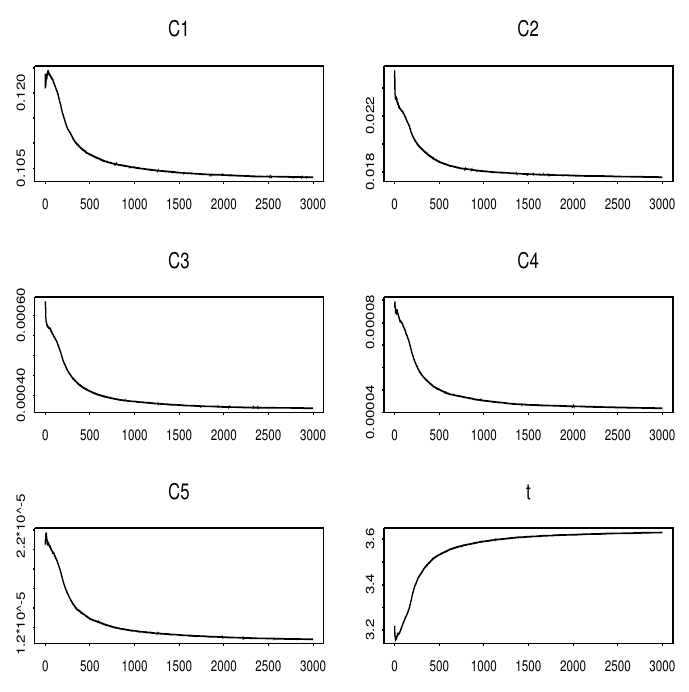
Figure 6. Convergence of the parameters using Griddy-Gibbs sampler.